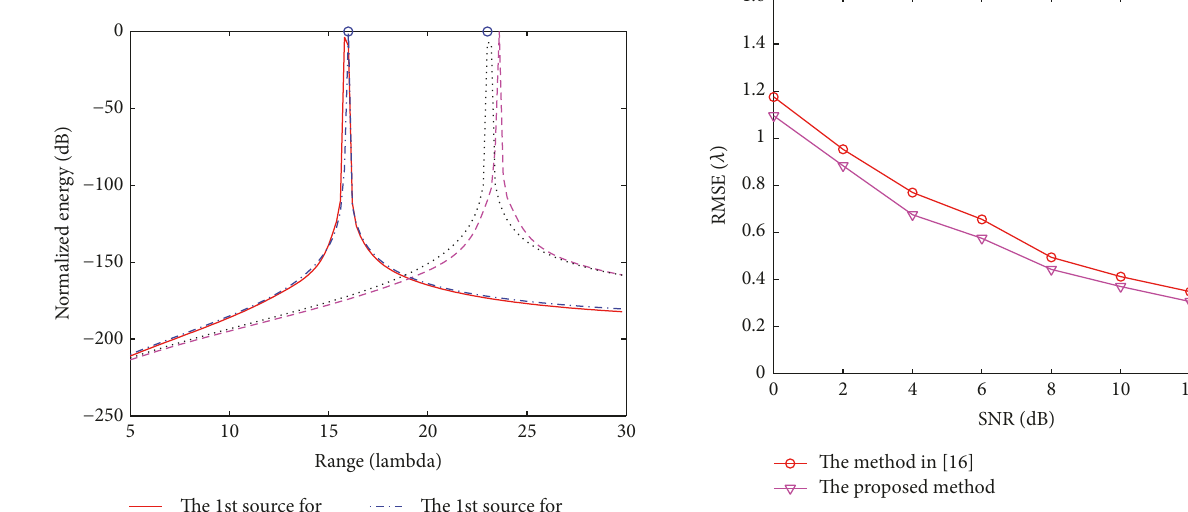
Figure 5: RMSE of range estimation versus